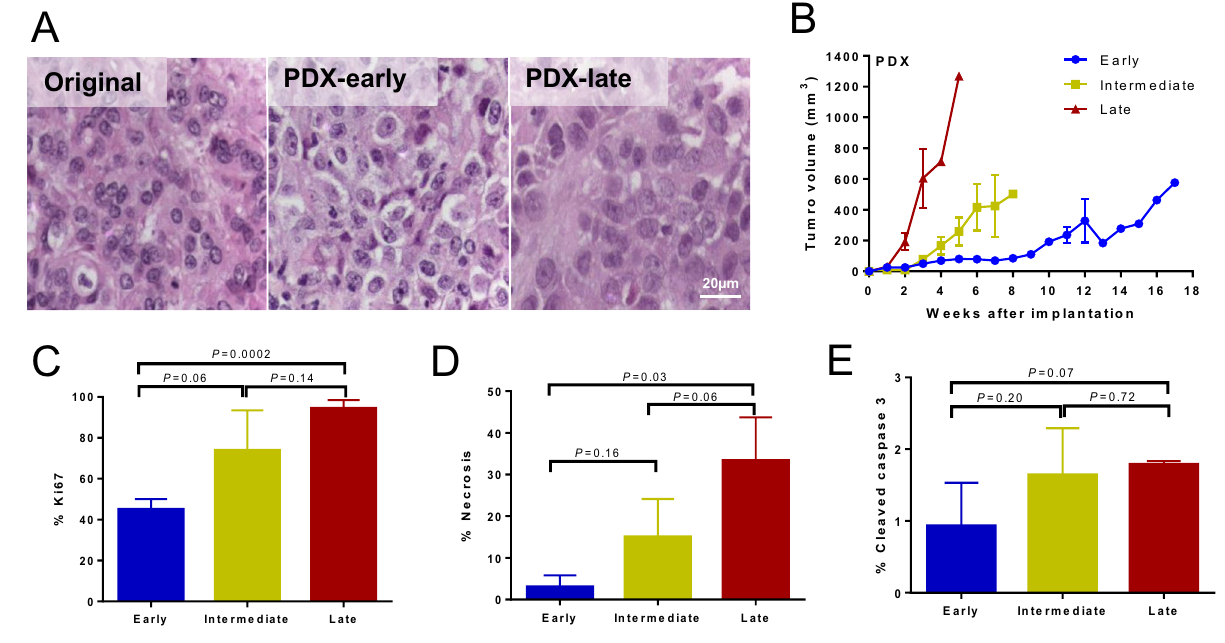
Figure 2. Bladder cancer PDX CoCaB 1 grows faster in late vs. early passages. ( A ) Representative IHC staining showing conserved high-grade urothelial carcinoma histology among original tumor, early, and late passages of PDX. Magnification 200×. Scale bar represents 20 µm. ( B ) CoCaB 1 PDX grows progressively faster in later passages (s6-8 late, s4 intermediate, s0-2 early; n = 8–10 for early and late passages, n = 4 for the intermediate passage). ( C – E ) Late passage PDX showed ( C ) an increase in the Ki67 proliferation index and ( D ) an increase in necrosis, but ( E ) no change in cleaved caspase 3 vs. early passage PDX.